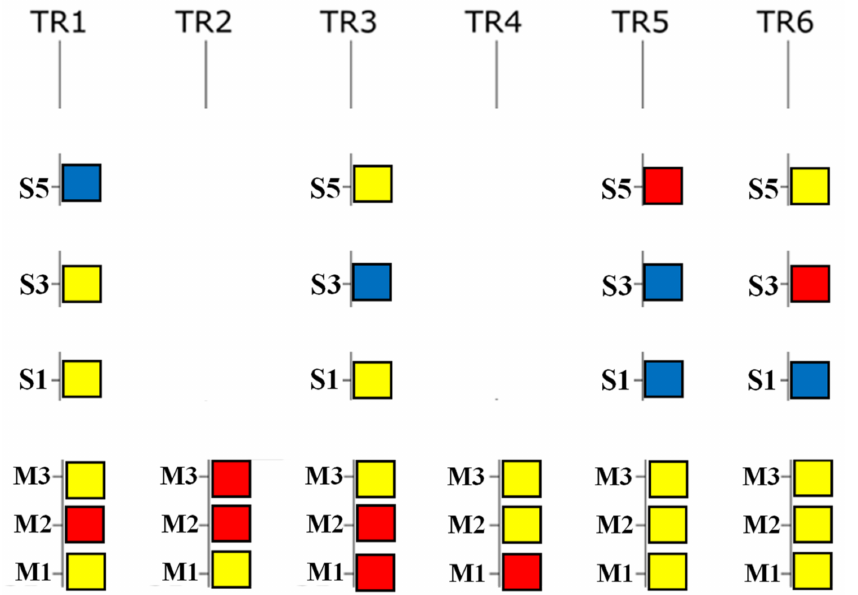
Figure 3. Percent contribution of mangrove-derived organic matter ( f mangrove ) within sampling stations. TR: transects (1–6). M: mangrove stations. S: saltmarsh stations. Red squares: 95% to >80%; Yellow squares: 80% to >50%; Blue squares: 50% to